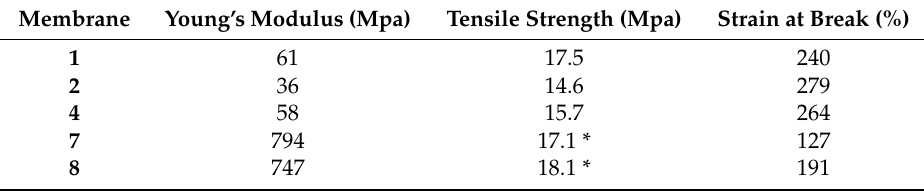
Table 6. Mechanical properties of selected membranes, as determined in static extension tests at 20 ◦